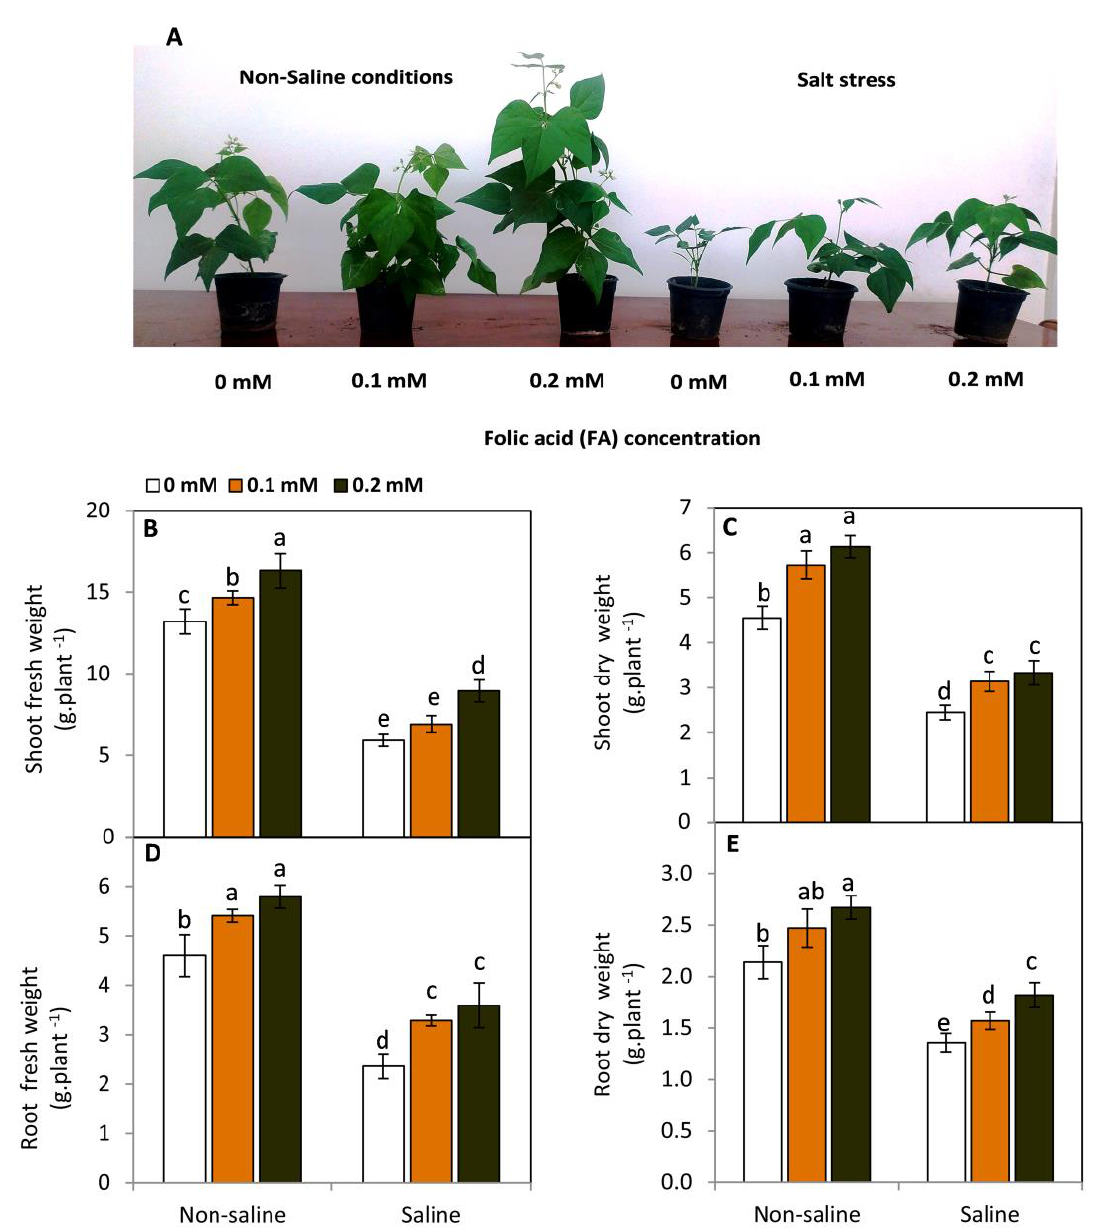
Figure 1. Effect of exogenous folic acid (FA; 0, 0.1, and 0.2 mM) on vegetative growth ( A ), shoot fresh weight ( B ), shoot dry weight ( C ), root fresh weigh ( D ) and root dry weight ( E ), of snap bean plants grown under non-stressed and saline-stressed (50 mM, NaCl) conditions. Values are the averages of three replicates ± SD. Different letters indicate significant differences according to Duncan’s multiple range tests ( p < 0.05).